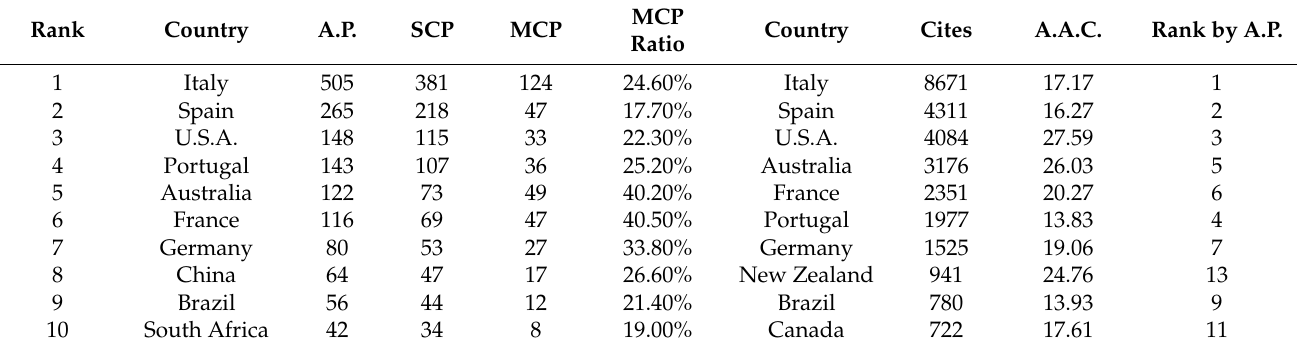
Table 8. Top-10 countries by scientific production and by number of